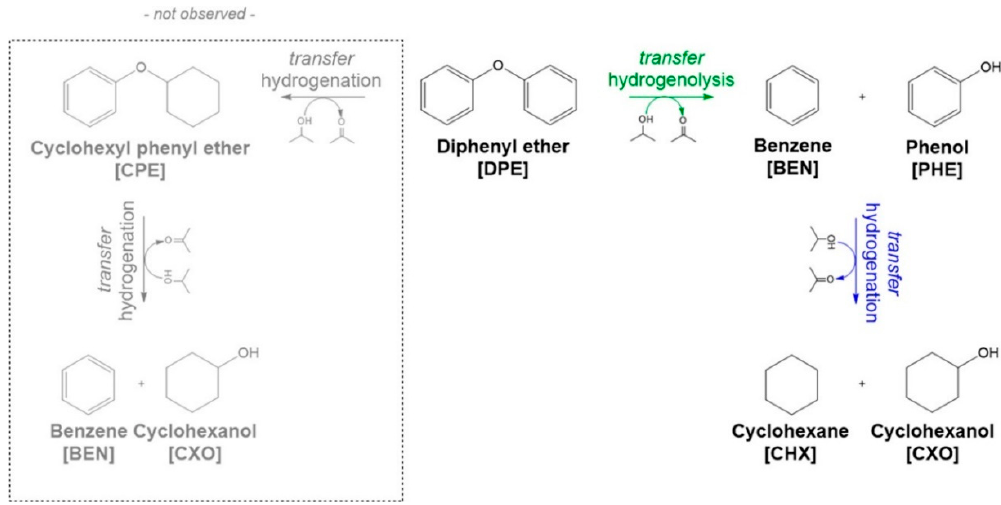
Figure 15. Possible catalytic pathways in the catalytic transfer hydrogenolysis of diphenyl ether for ref [69] .